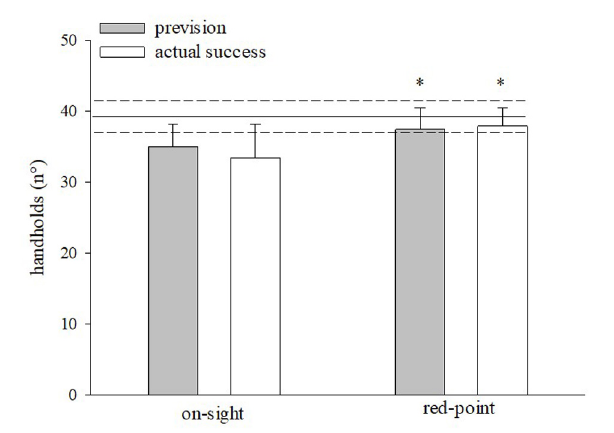
TABLE 2 | Physiological and perceptual parameters at baseline, during, and post on-sight and red-point lead climb. On-sight lead climb FIGURE 2 | Number of the handholds grasped by the climber in the on-sight and the red-point ascent (before finishing the route or before falling) and the pre-climb prevision. Mean ± SD ∗ P < 0.05 vs.